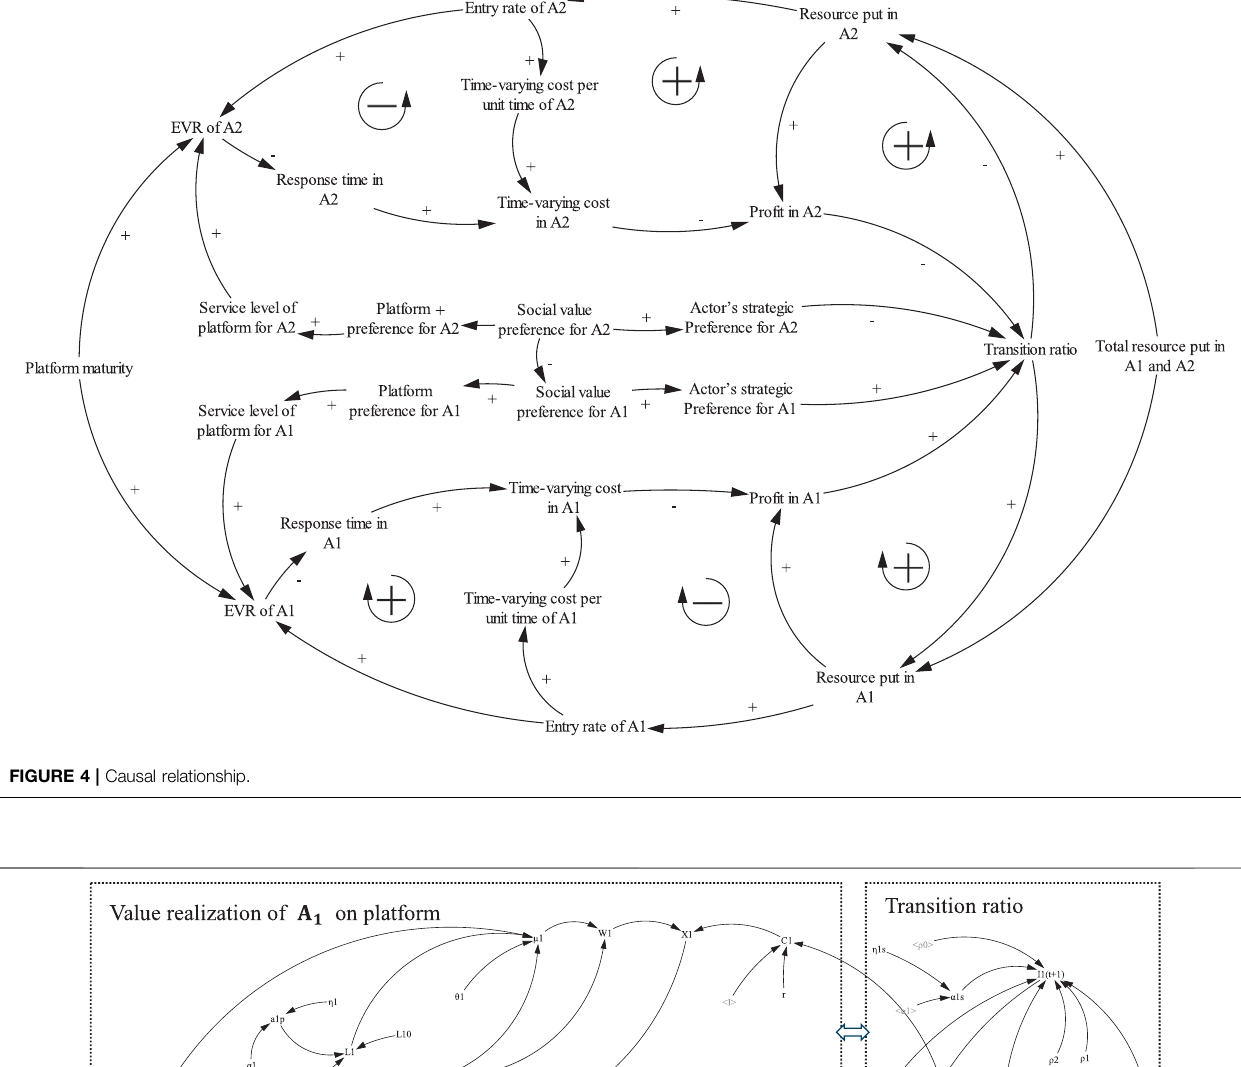
FIGURE 4 | Causal relationship.